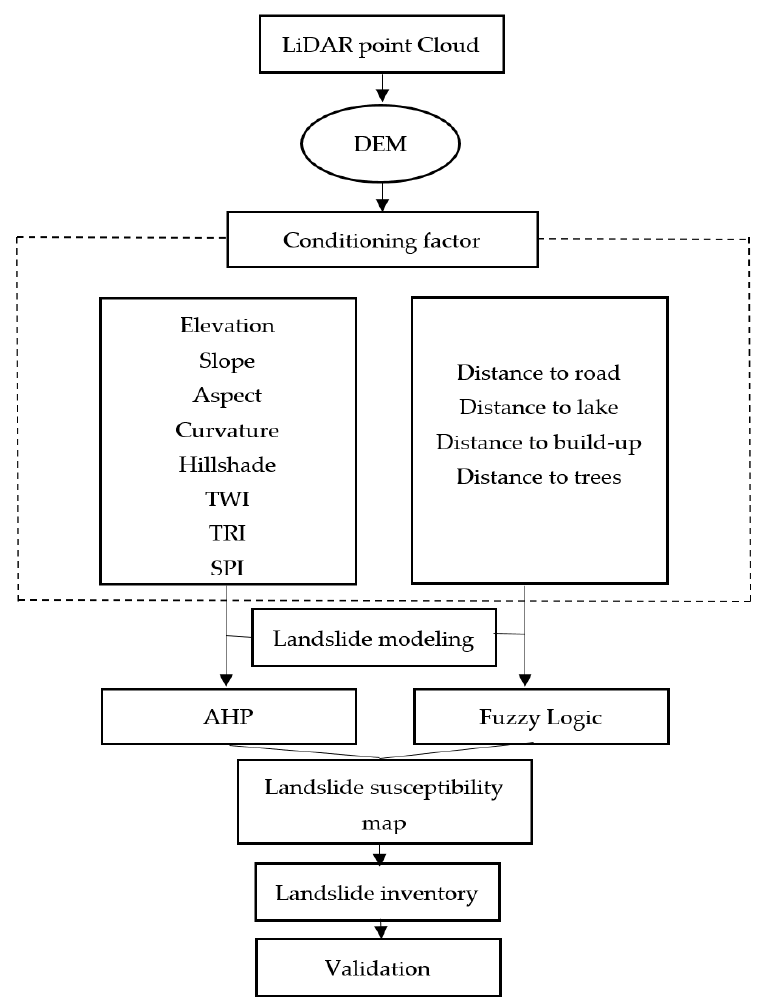
Figure 4. Flowchart of the methodology for landslide susceptibility.